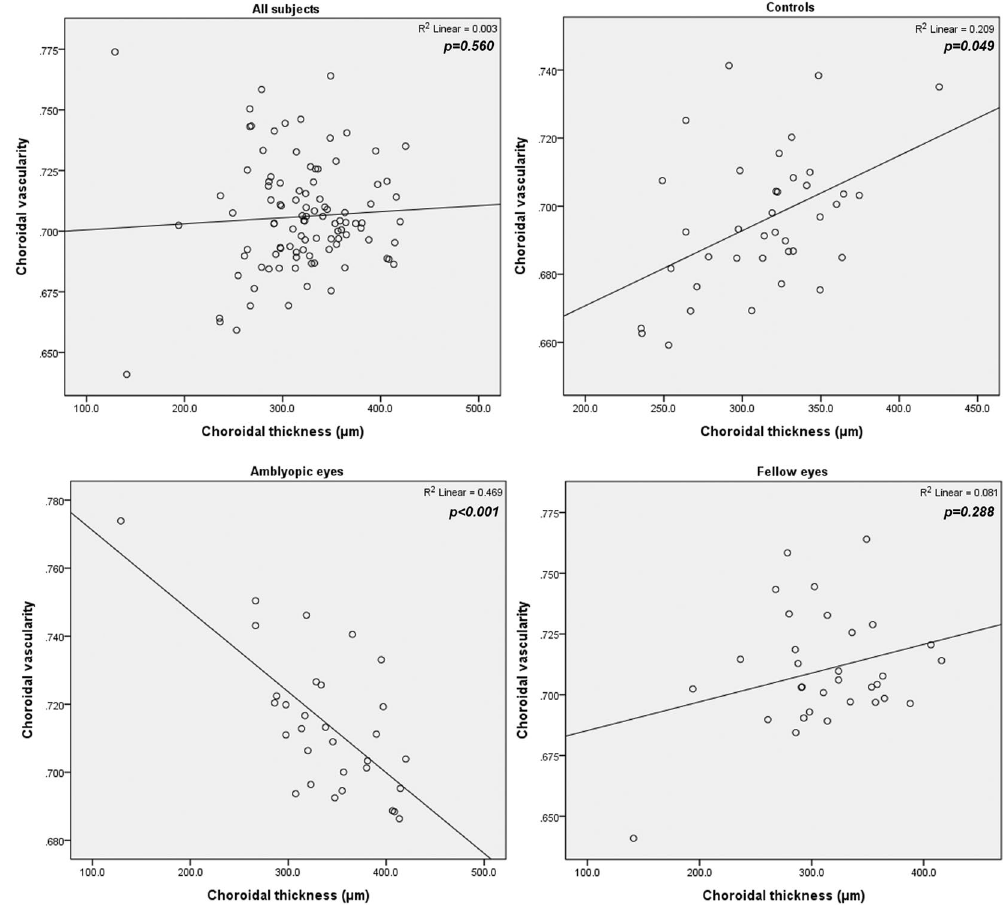
Figure 3. Correlation between choroidal vascularity and subfoveal choroidal thickness. In all eyes analyzed together, no significant correlation was measured ( P = 0.560). In amblyopic eyes, a negative correlation between subfoveal choroidal thickness and choroidal vascularity was found ( r = − 0.684, P < 0.001), whereas a positive correlation was found in normal eyes (r = 0.47, P =